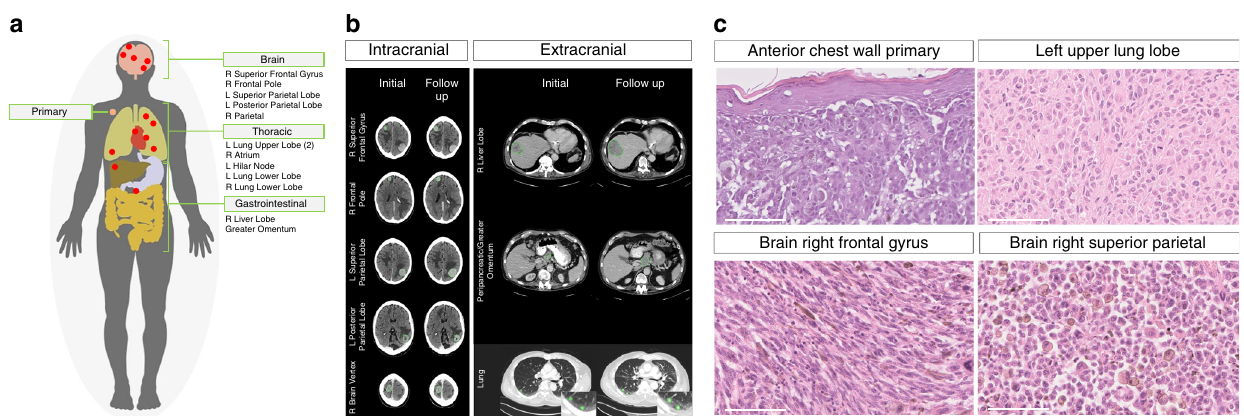
Fig. 1 Clinical presentation and sequalae of index autopsy case. a Sites of 13 metastases sampled during the autopsy and the anterior chest wall cutaneous primary melanoma. b Axial CT imaging from the brain, chest and abdomen before (left) and after (right) whole brain radiotherapy (imaging 5 weeks apart). Brain CT images represent the following metastatic sites (from top to bottom); right superior frontal gyrus, right frontal pole, left superior parietal, left posterior parietal and right brain vertex (the latter corresponding to the ‘ right parietal ’ sample labelled in the remainder of the text). Chest/ abdomen CT images represent the following metastatic sites (from top to bottom); right lobe of liver, peripancreatic/greater omentum (corresponding to the ‘ greater omentum ’ sample labelled in the remainder of the text) and right lower lung. c Histological analyses (Hematoxylin-eosin images), from top left to bottom right; primary melanoma from the anterior chest wall, distant metastasis from; the left upper lobe of the lung, right frontal gyrus of the brain and right superior parietal lobe of the brain. Morphological appearances differ across the tumours, including varying cellular morphology and pigmentation. One representative region from each tumour sample is shown. The thick white line represents 100 µ m in 40-fold magni fi